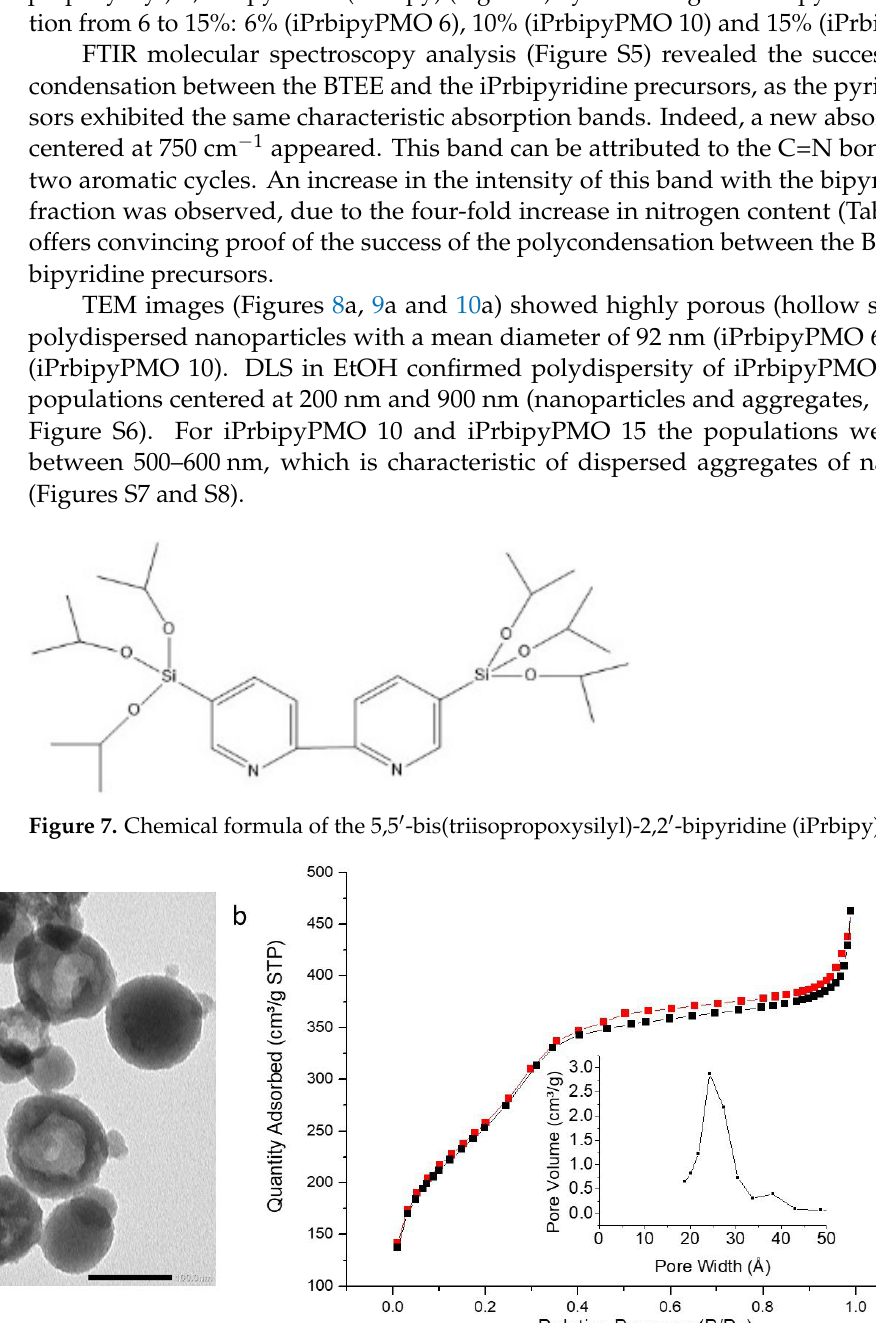
Figure 8. ( a ) TEM image of iPrbiPyPMO 6 scale bar 100 nm. ( b ) Nitrogen adsorption–desorption at 77 K. Insert BJH desorption (dV/dlog(w)) Pore Volume.